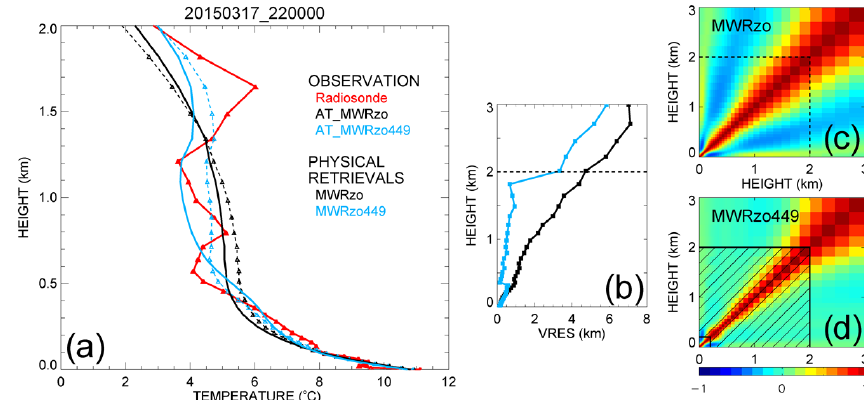
Figure 3. (a) Observed temperature profiles from radiosonde in red, from ATkernel -smoothed radiosonde, AT_MWRzo in dashed black, and AT_MWRzo449 in dashed light blue; PRs from MWRzo PR in solid black, and from MWRzo449 PR in solid light blue. (b) Vertical resolution (VRES) as a function of the height for the MWRzo PR (black) and for the MWRzo449 PR (light blue). (c, d) 3 × 3km (37 × 37 levels) S op matrices, converted to correlation matrices, for the MWRzo PR (c) and for the MWRzo449 PR (d) . Dashed lines on plots (b–d) mark 2km a.g.l. Hatched area on panel (d) marks the RASS measurement